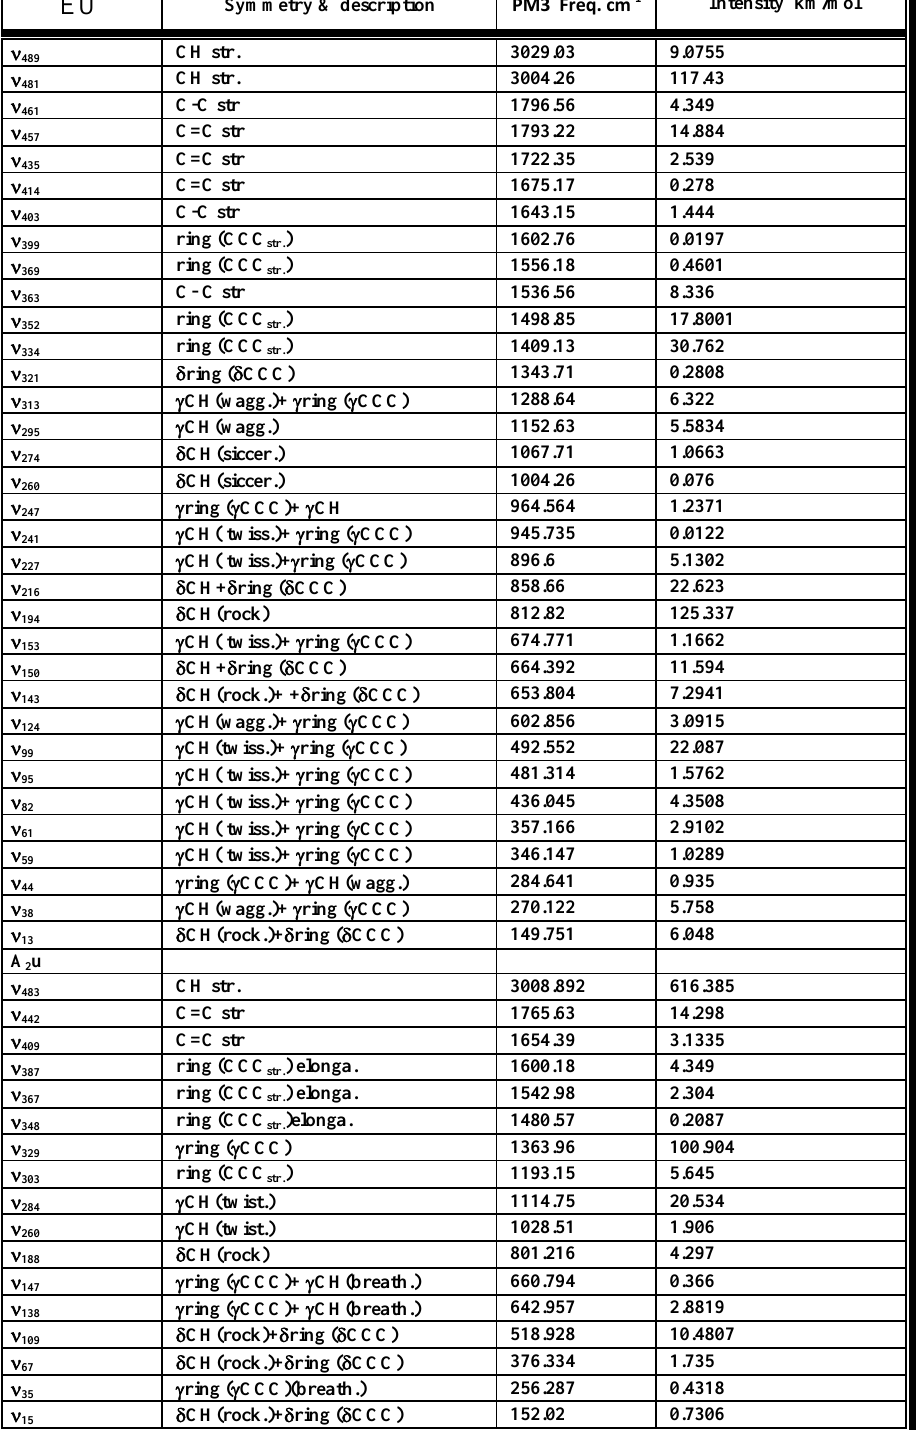
Table 6: Vibration frequencies and IR absorption intensities for (tetra-rings layer (C as calculated applying G03